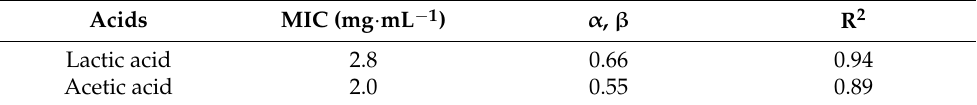
Figure 1. Curves S. aureus growth inhibition: Comparison of experimental and predicted data. Each specific growth rate value of the pathogen is the average of three measurements ( p = 0.05). Table 1. Inhibition constants of S. aureus monoculture and R 2 values of